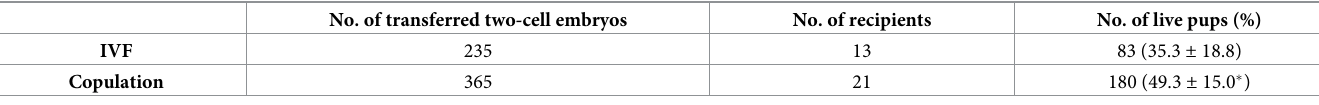
Table 2. In vivo developmental ability of embryos obtained via postovulatory